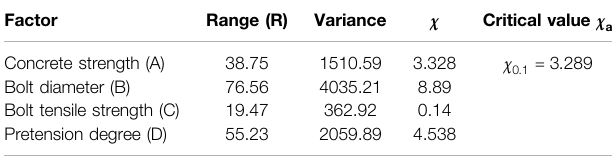
TABLE 5 | Range and variance analysis results of the post-slip stiffness of HSFGBs.